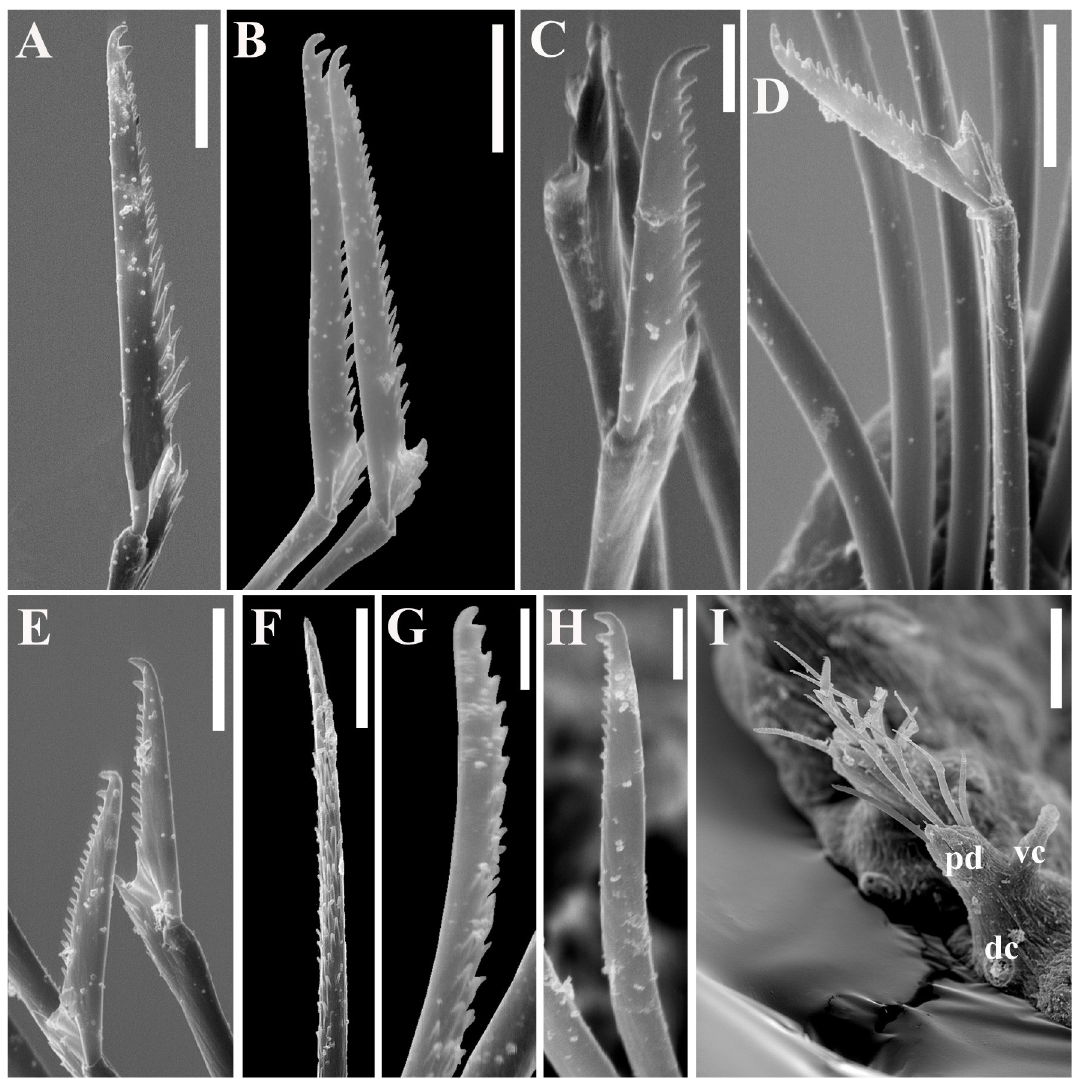
Fig 4. Salvatoria nitiduloides n. sp., SEM. (A, B). Dorsalmost falcigers, anterior parapodium; (C). Ventralmost falcigers, parapodium 2; (D). Ventralmost falciger, midbody parapodium; (E). Ventralmost falcigers, posterior parapodium; (F–G). Dorsal simple chaetae, posterior parapodium; (H). Ventral simple chaeta, posterior parapodium; (I). Posterior parapodia, frontal view. pd –parapodial lobe; vc –ventral cirrus; dc –scar of dorsal cirrus insertion (cirrus absent). Scale bars: A–B, D–F, 5 μ m; C, G–I, 2 μ